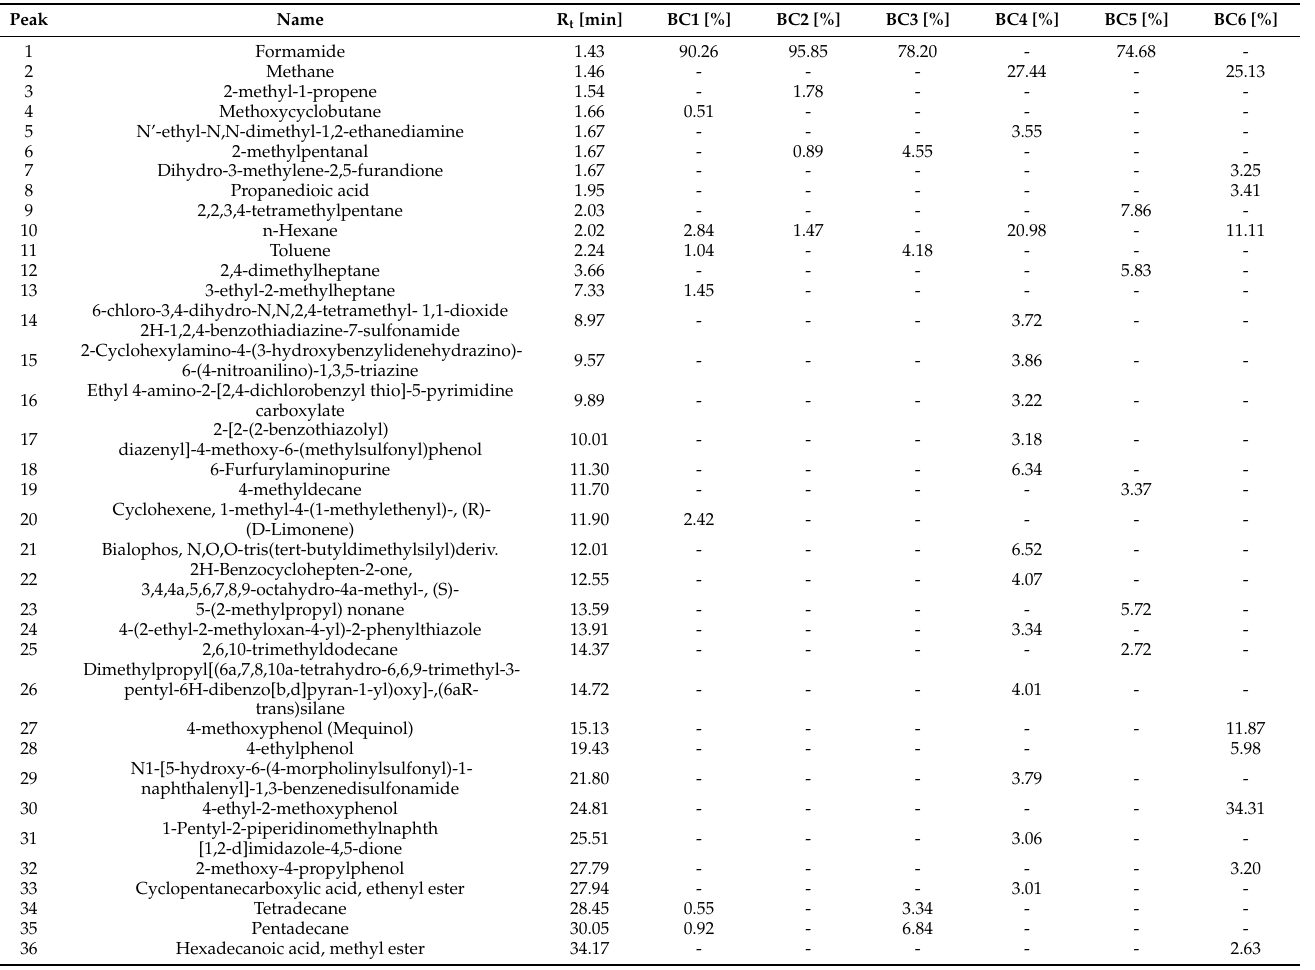
Table 3. Qualitative analysis of volatile organic compounds emitted by biochars (measured with